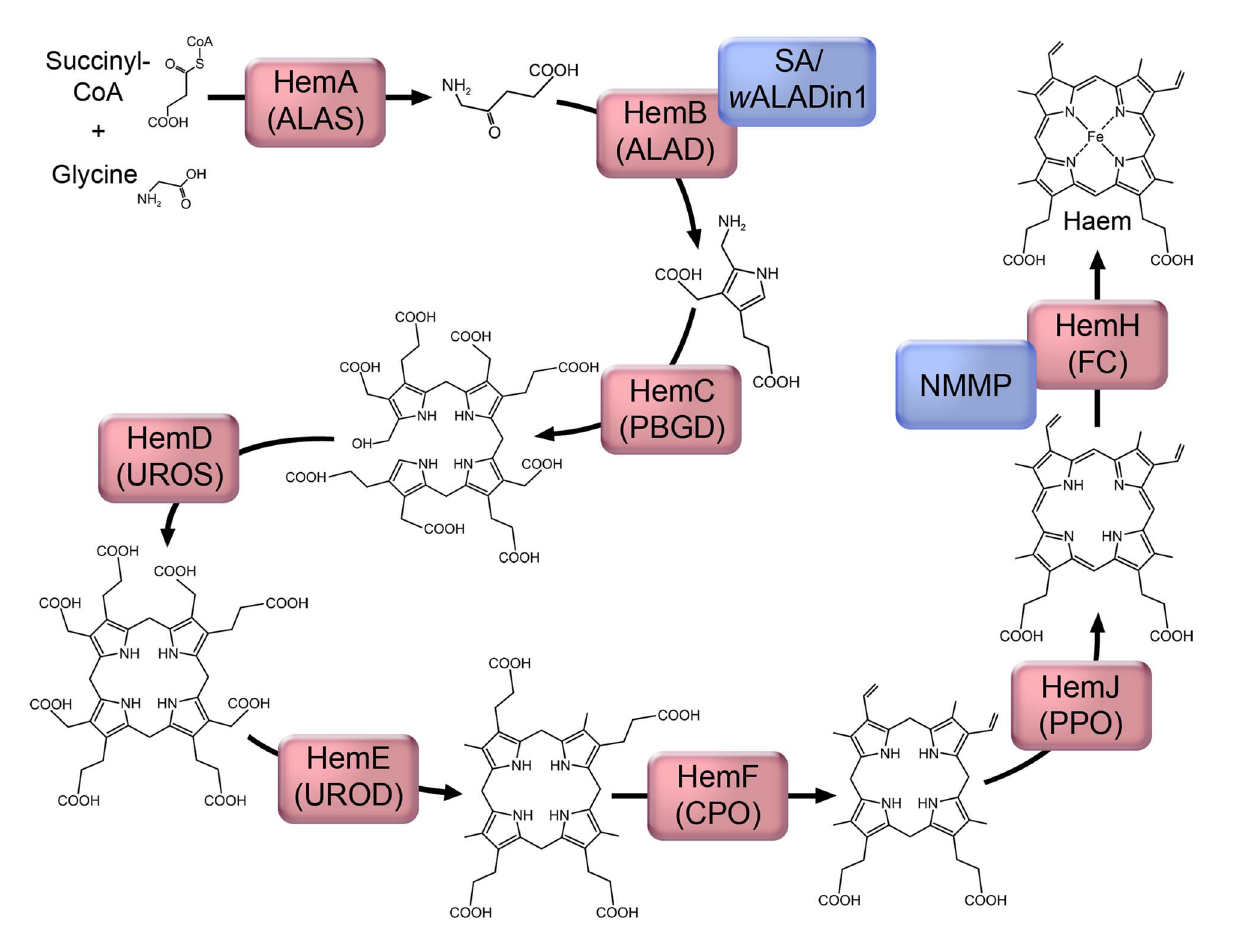
Figure 3. The proposed haem synthesis pathway in Wolbachia , showing structural intermediates. Enzymes are represented by red boxes, which contain the protein name in Wolbachia and the abbreviated enzyme name: ALAS, 5-aminolevulinate synthase; ALAD, 5-aminolevulinate dehydratase; PBGB, porphobilinogen deaminase; UROS, uroporphyrinogen III synthase; UROD, uroporphyrinogen III decarboxylase; CPO, coproporphyrinogen III oxidase; PPO, protoporphyrinogen IX oxidase; FC, ferrochelatase. Inhibitors of the pathway are represented by blue boxes, for which abbreviations used are as in the text.